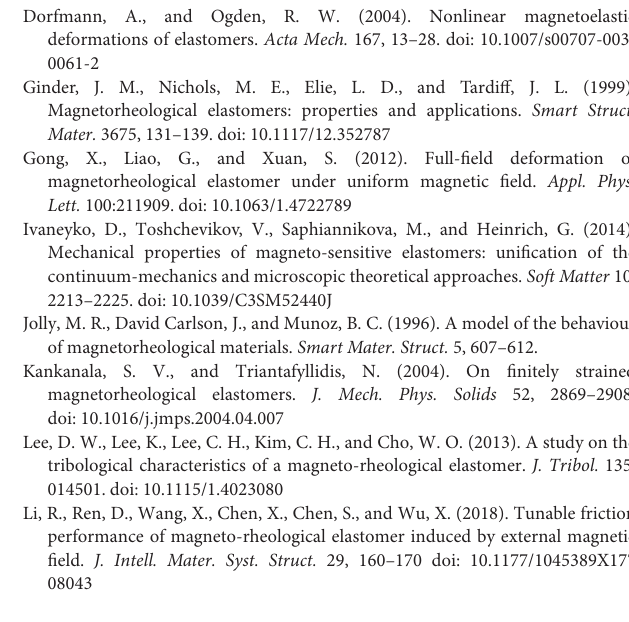
Figure 5 gives the white light interferometer test results of a 10% particle volume fraction MRE that is generated by iron mold. Figure 5A gives the initial surface contour of the MRE, Figure 5B gives the surface contour of MRE under a uniform vertical magnetic field of 450 mT, and Figure 5C gives the 2 dimension picture of the MRE surface profiles with/without a uniform vertical magnetic